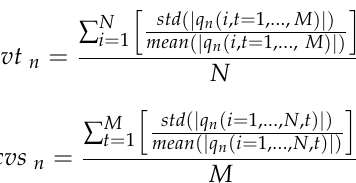
Figure 11. Wall-to-fluid heat flux averaged over time, as a function of the axial coordinate for three meaningful channels (horizontal orientation, Q = 100 W).